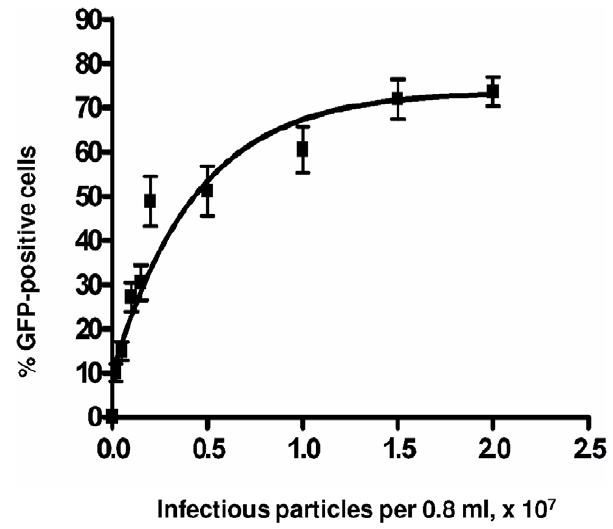
Figure 2. RT43.2GFP gammaretroviral vector transduction into differentiated PC12 cells: effect of increased viral titer. After five days of NGF treatment, differentiated PC12 cells grown on 4-well chamber slides coated with Matrigel were exposed to concentrations of viral particles ranging from 2.0 6 10 5 to 2.0 6 10 7 RT43.2GFP vector particles in the presence of NGF. Three days after exposure to vectors, cells were photographed with a 20 6 objective, using a FITC or DAPI filter, after addition of DAPI. Transduction efficiency is expressed as the mean of the percentage of DAPI-positive cells expressing GFP (ordinate) from several fields for each transduction experiment, for different titers of vector particles (abscissa). either lentiviral or gammaretroviral vectors develops progressively within 2–3 days after transduction, consistent with viral integra- tion, gene transcription, and translation of GFP mRNA, and